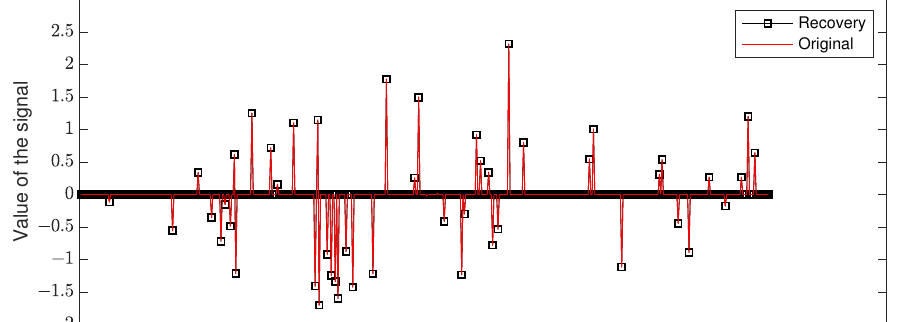
Figure 1. The recovery of an input signal in dimension N = 512 with sparsity level K = 50, number of measurements M = 200 and s = 5.